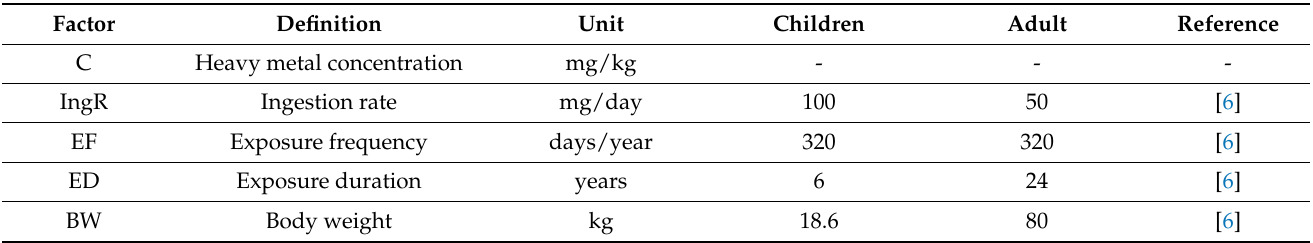
Table 1. Assessment of heavy metal pollution and risks to human